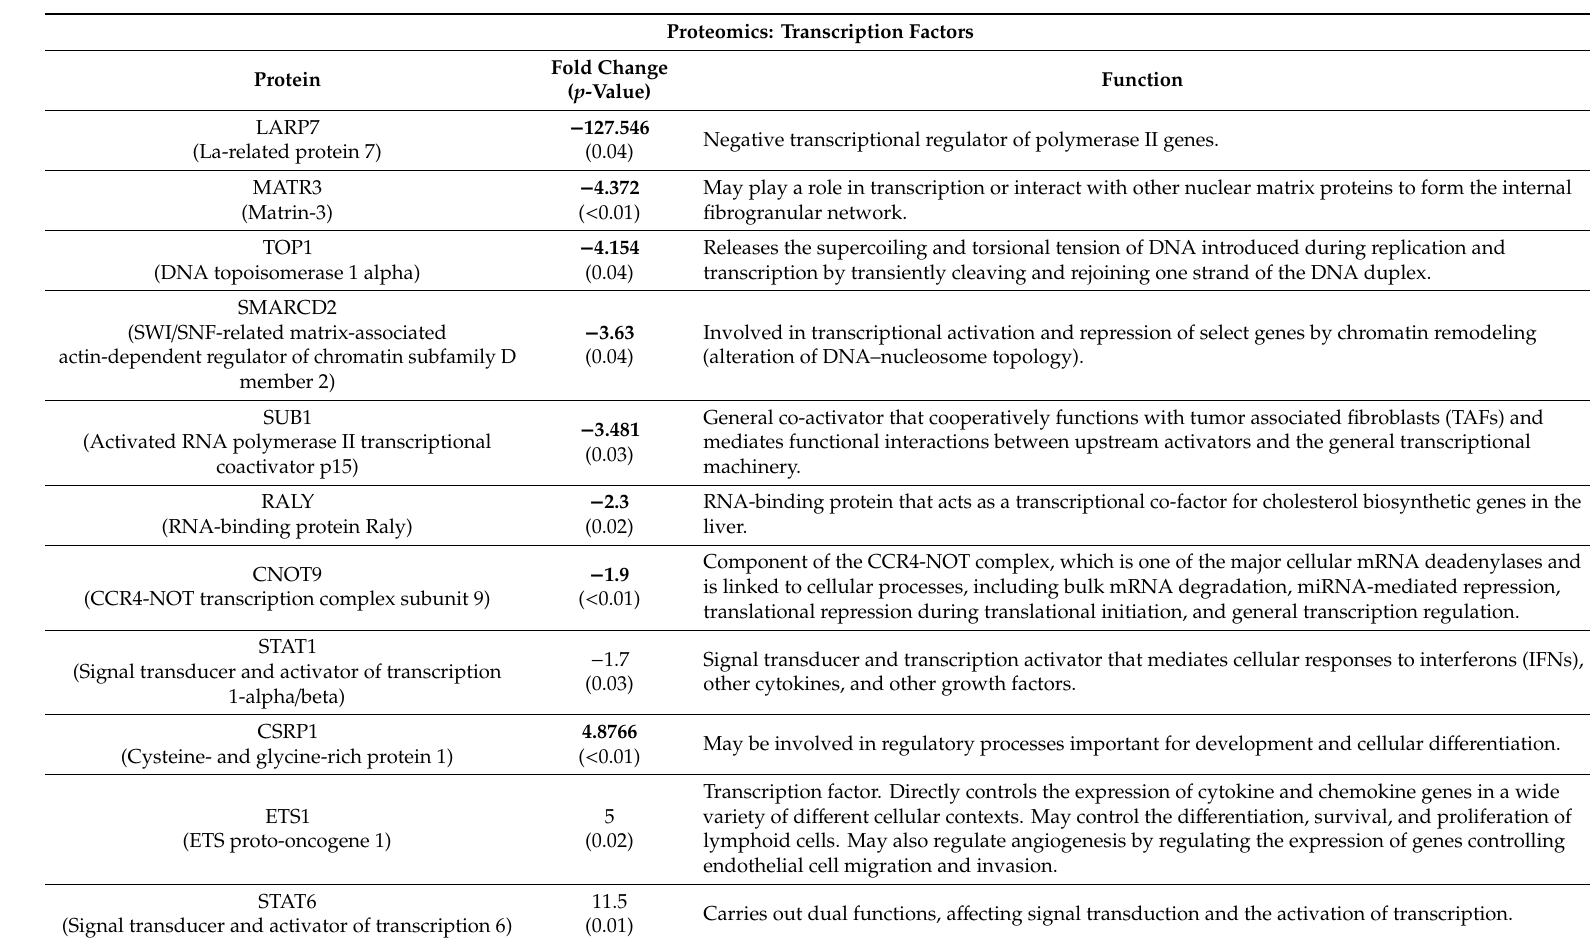
Table 4. Transcription factors di ff erentially expressed in si-NT-TTs and si-hVDAC1-TTs, as identified by LC-HR MS / MS. LC-HR MS / MS experiments were performed as described in the Materials and -Methods section. Proteins di ff erentially expressed between si-NT-TTs and si-hVDAC1-TTs ( p -value < 0.01, FC ≥ | 2 | ) are presented, along with the name, fold change, and p -value, as well as